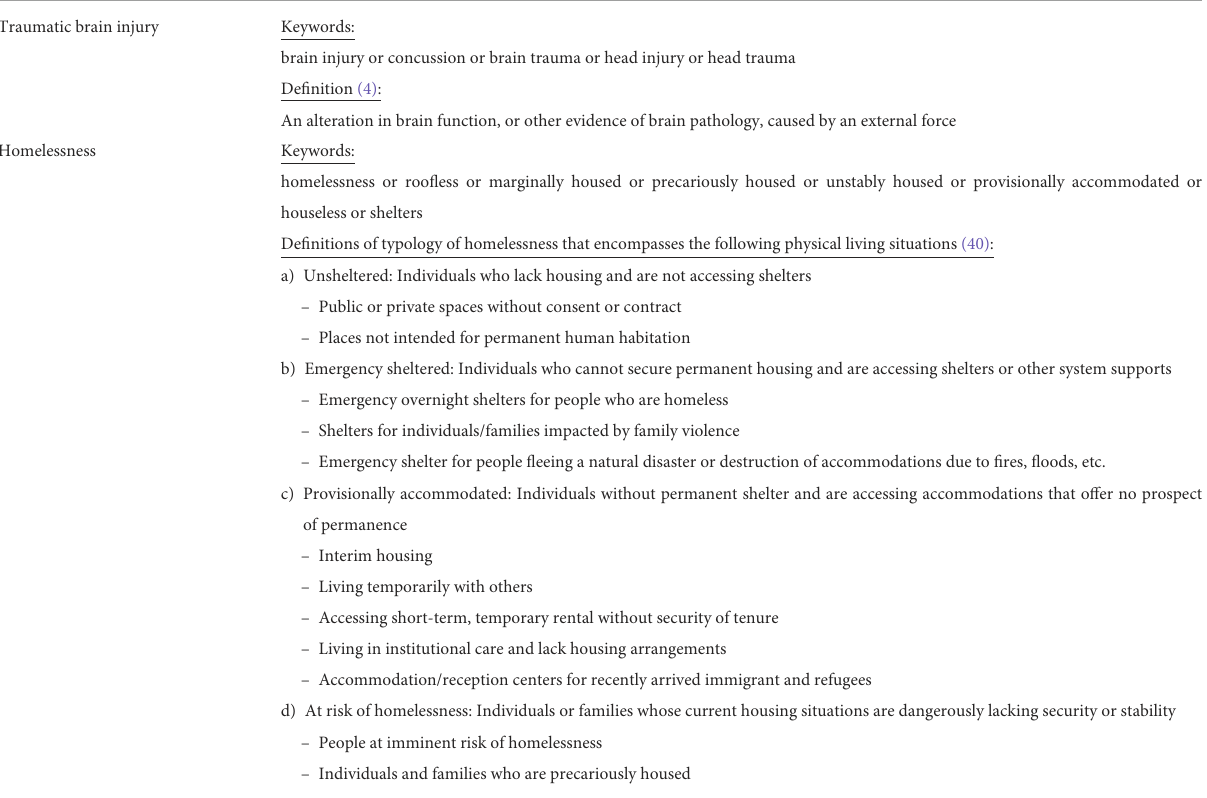
TABLE 2 Keywords and definitions for traumatic brain injury and homelessness. Keywords describing TBI/homelessness or content consistent with the definition